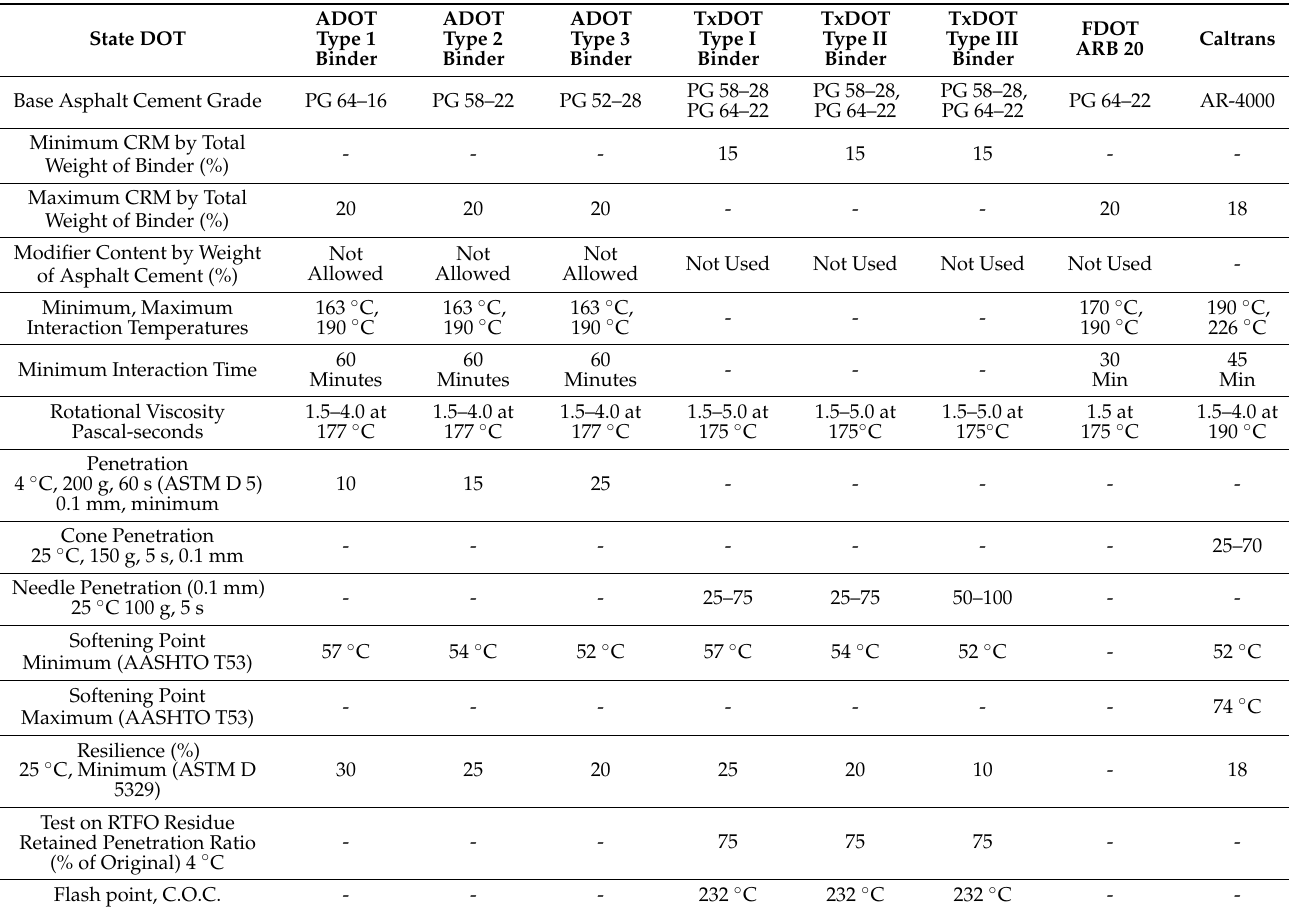
Table 7. Specifications for on-site blended CRM